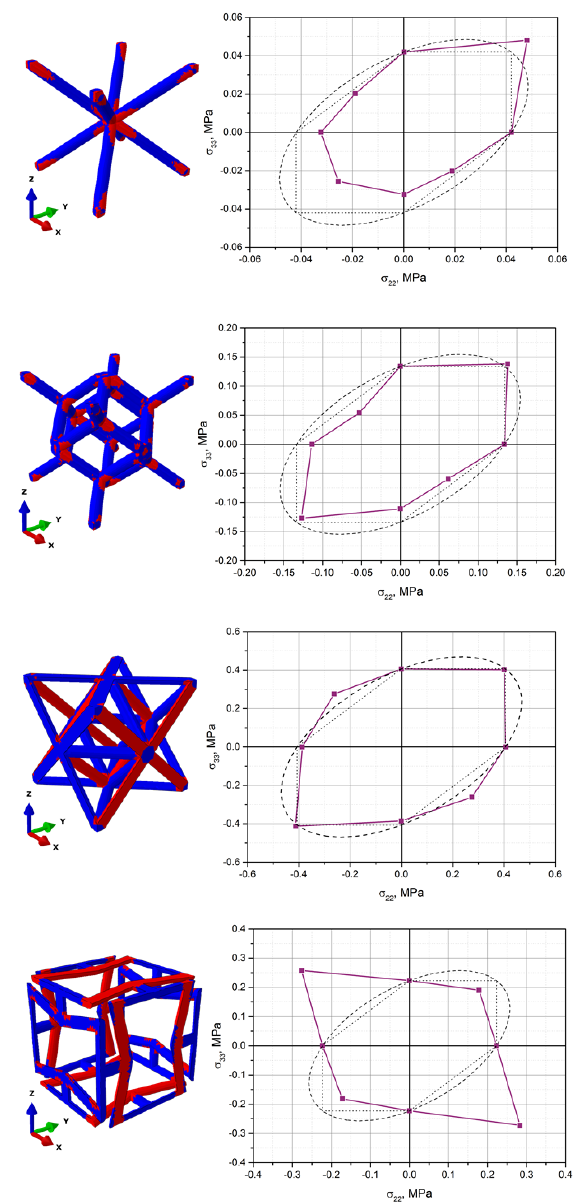
Figure 11. Initial Yield Surface: Str. 3, 4, 6,